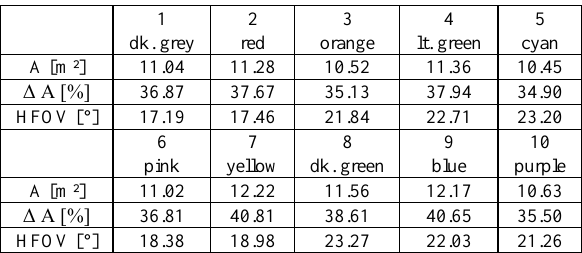
Table 3. Overview of the simulated viewpoints